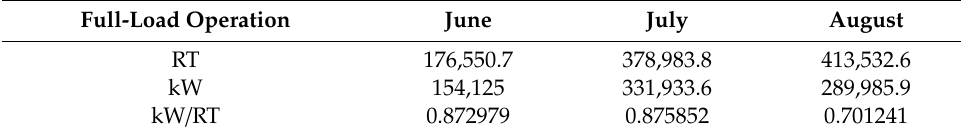
Table 2. Data of HVAC system operated at full load.